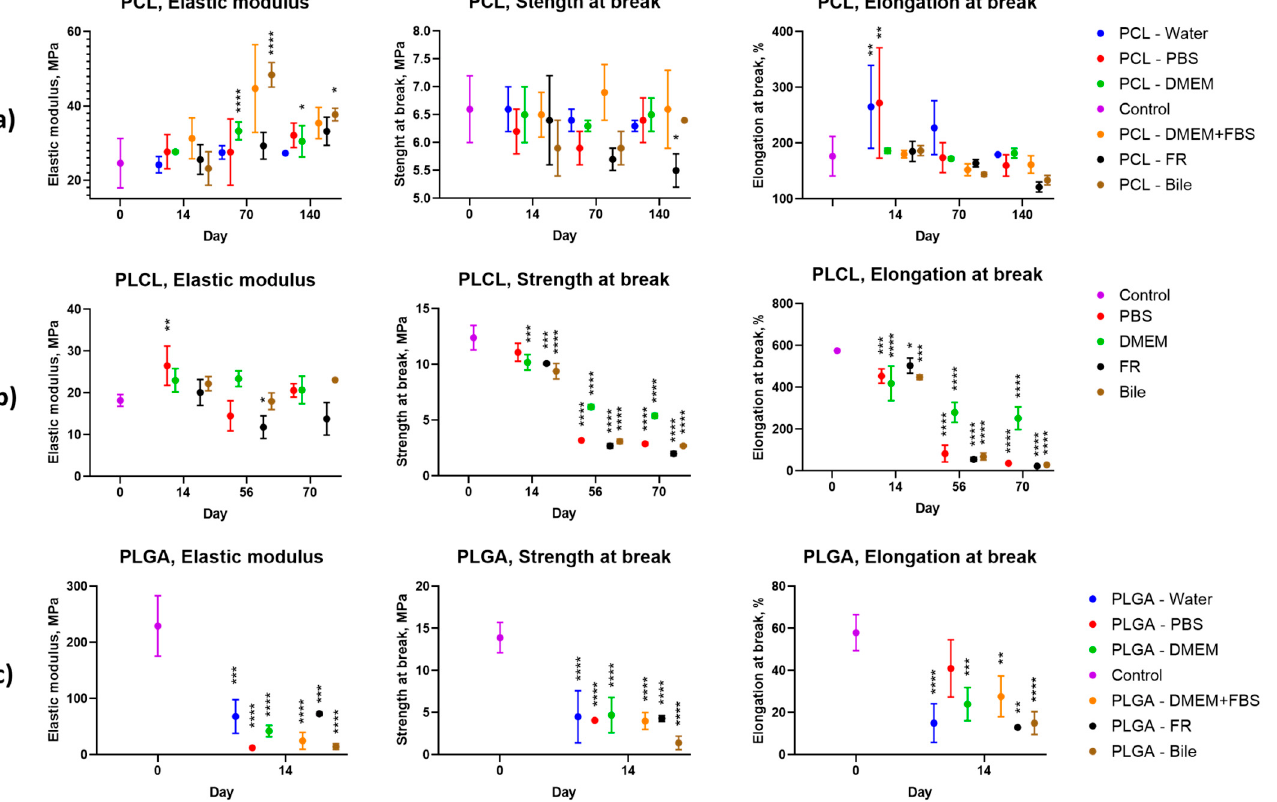
Figure 5. Dependence of elastic modulus, strength, and strain at break of biocompatible scaffolds based on: ( a ) PCL; ( b ) PLCL; ( c ) PLGA on conditions of degradation process. Control—mechanical properties of original samples. *— p -value<0.05; **— p -value<0.01; ***— p -value<0.001; ****— p -value < 0.0001.